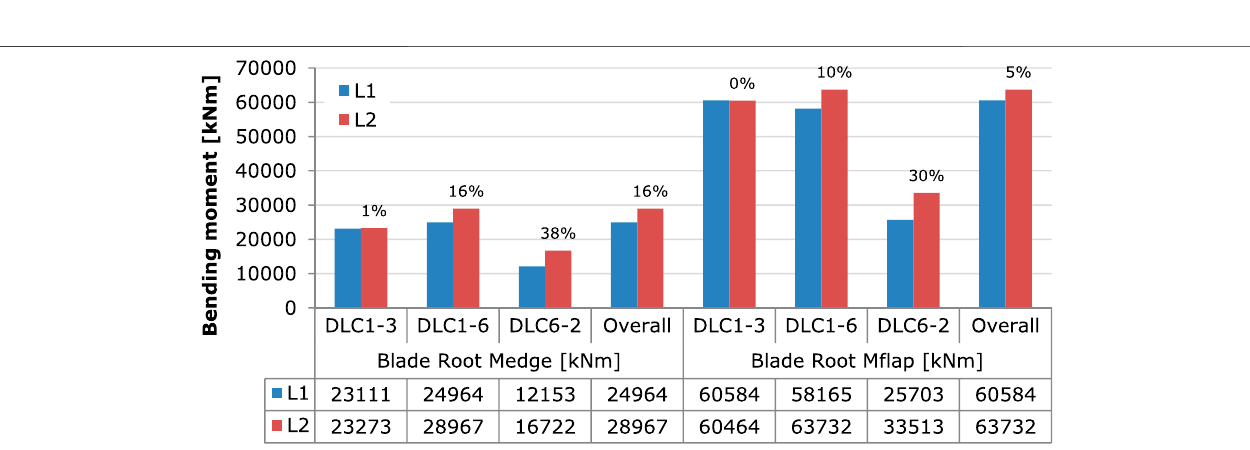
Frontiers in Energy Research |